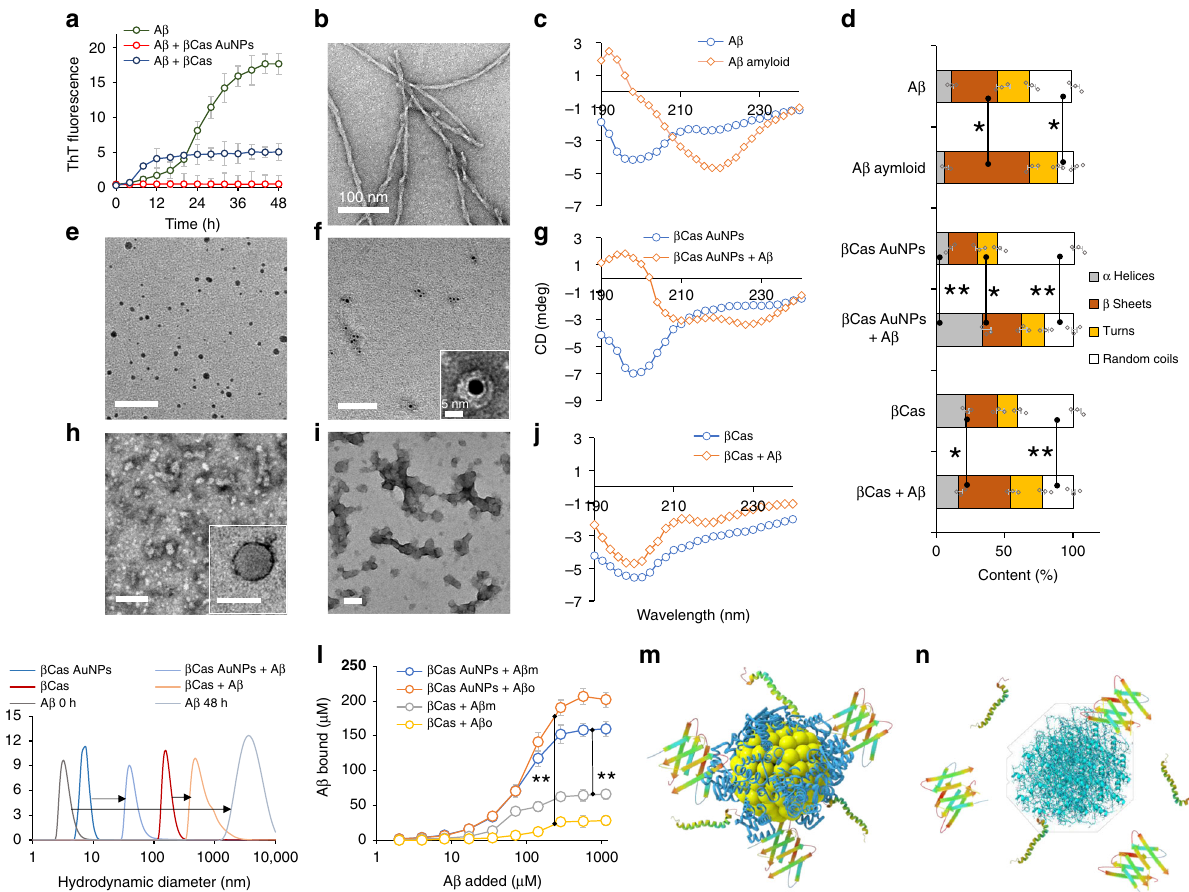
Fig. 1 In vitro inhibitory interactions between β Cas AuNPs and β Cas with A β . a ThT assay of A β alone (50 µ M) and in the presence of β Cas AuNPs (equivalent to 6.25 µ M of β Cas) and β Cas (6.25 µ M) ( n = 4). β Cas AuNPs completely inhibited while β Cas decreased ( p < 0.005) the lag time and plateau ThT fl uorescence of A β fi brillization. b TEM image of fi brillized A β . c CD spectra of A β (100 µ M) before and after fi brillization indicate conformation change from random coils (198 nm peak) to β -sheets (220 nm peak). d Secondary structure of A β (100 µ M) fi brillized with and without β Cas AuNPs or β Cas ( n = 4). TEM images of β Cas AuNPs before ( e ) and after incubation with A β ( f ; inset shows A β corona on a β Cas AuNP). g CD spectra of β Cas AuNPs before and after incubation with A β . TEM images of β Cas before ( h ) and after ( i ) incubation with A β . j Appearance of a negative peak at 218 nm in CD spectra of β Cas + A β indicates limited A β fi brillization into β -sheets. After binding with A β , the α -helix contents of β Cas AuNPs were decreased signi fi cantly ( p < 0.05) from 56 to 21%; while in the case of β Cas, α -helices decreased from 41 to 22% ( p < 0.005) and β -sheets increased from 24 to 38% ( p < 0.05). k Hydrodynamic radius of A β before and after fi brillization in the presence and absence of β Cas AuNPs or β Cas. l Quanti fi cation of binding capacity of β Cas AuNPs or β Cas with A β m or A β o ( n = 4). β Cas AuNPs (6.25 µ M β Cas equivalent) were able to bind up to 152.3 ± 13.4 and 190.7 ± 10.9 µ M of A β m and A β o. β Cas (6.25 µ M) was only able to adsorb 62.4 ± 3.4 and 26.4 ± 4.6 µ M of A β m and A β o, indicating a signi fi cant ( p < 0.005) increase in A β binding capacity of β Cas in the form of β Cas AuNPs. m , n Enhanced binding of A β m and A β o with β Cas promoted by the AuNP substrate. Scale bars in TEM images is 100 nm, while F inset is 5 nm. Error bars represent the standard deviation. Source data are provided as a Source Data fi